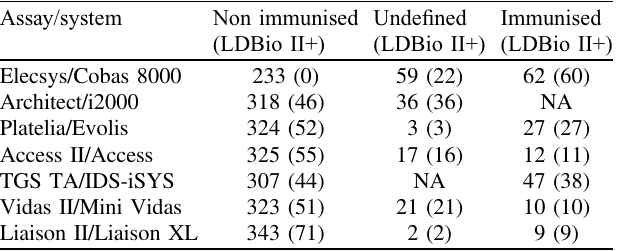
Table 2. Number of patients not immunised, unde fi ned and immunised according to manufacturers ’ thresholds (number of LDBio II positive for each case, N = 82).